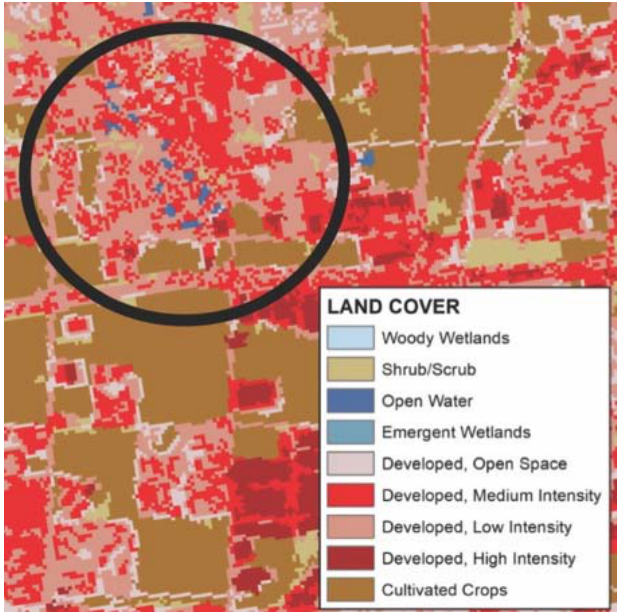
Figure 2. Land cover map of the study area (circled). Source: Land Cover Data—United States Geological Survey (USGS); Satellite image—Google Earth.